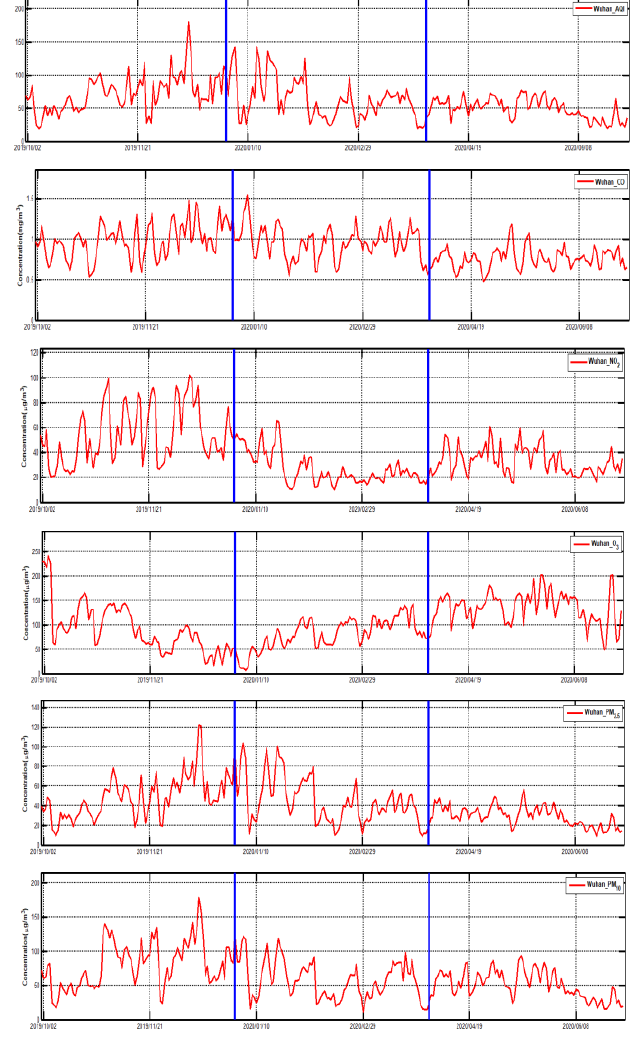
Figure 5: Time series of ground-based concentration of AQI, CO, NO 2 , O 3 , PM 2.5 and PM 10 measured in Wuhan during 0ctober 2019- July 2020, from three months before, during and after the